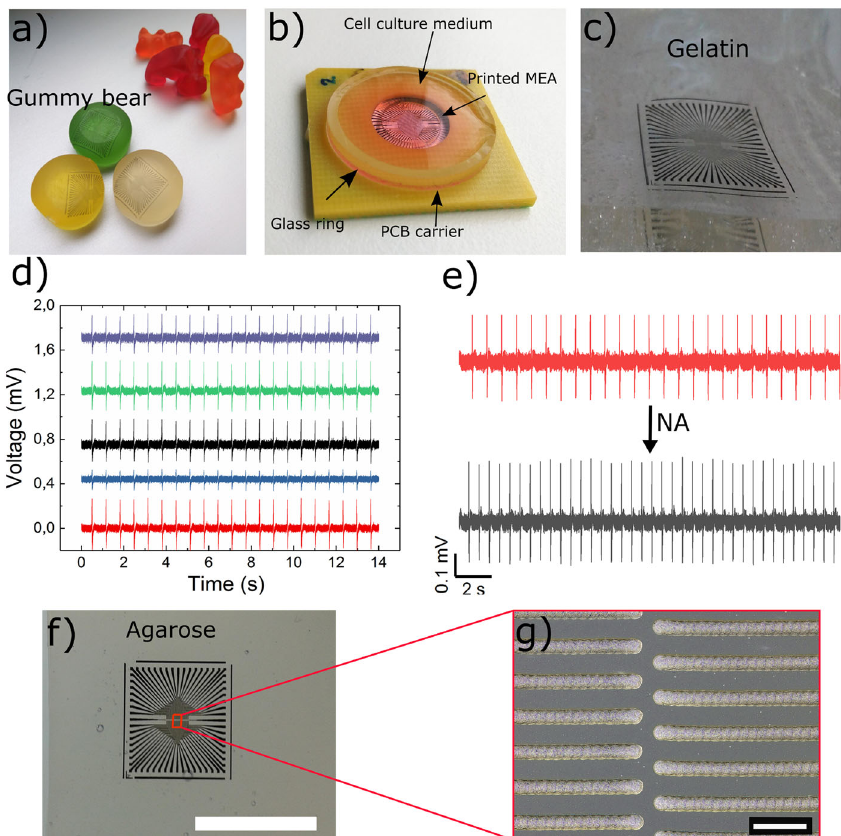
Fig. 4 Printed MEA on soft hydrogel substrates for extracellular recording. a Photograph of printed carbon MEAs on a gummy bear substrate. b Final chip bonded to printed circuit board with HL-1 cells culture. c Exemplary photograph of a printed MEA on a gelatin substrate. d Action potential recording from HL-1 cells using printed carbon MEAs on a gummy bear substrate, traces are offset in y -direction for clarity of representation. e HL-1 cells stimulation with noradrenaline (NA). f Photograph of a printed MEA on an agarose substrate (scale bar 10 mm). g Microscopic image of printed MEA on an agarose substrate (scale bar: 100